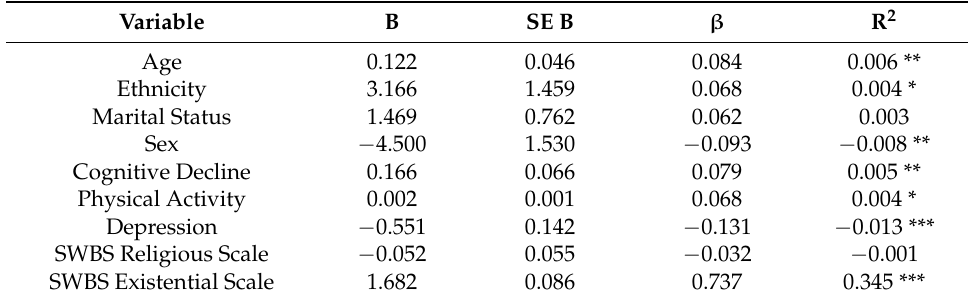
Table 3. Summary of Regression Analysis for Variables Predicting Pemberton Remembered Happiness Index (PHI